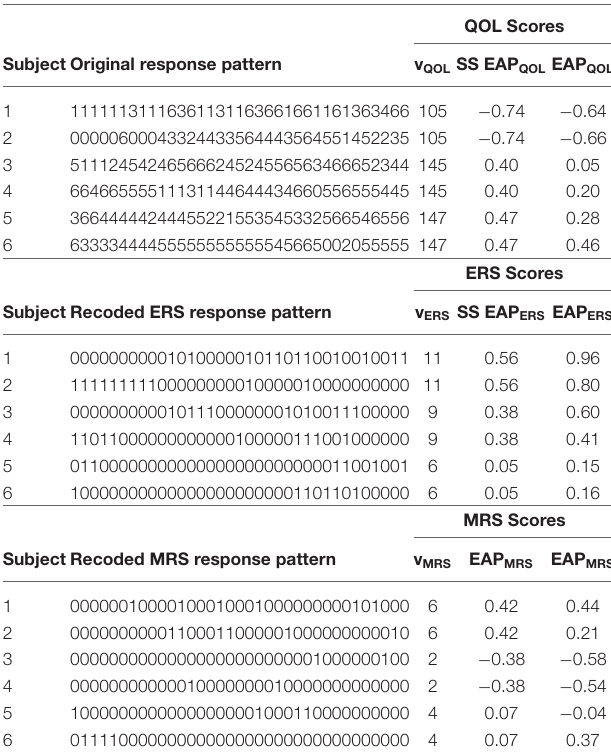
TABLE 1 | Some important symbols used in this manuscript. TABLE 2 | Example response patterns, sum scores, and EAP